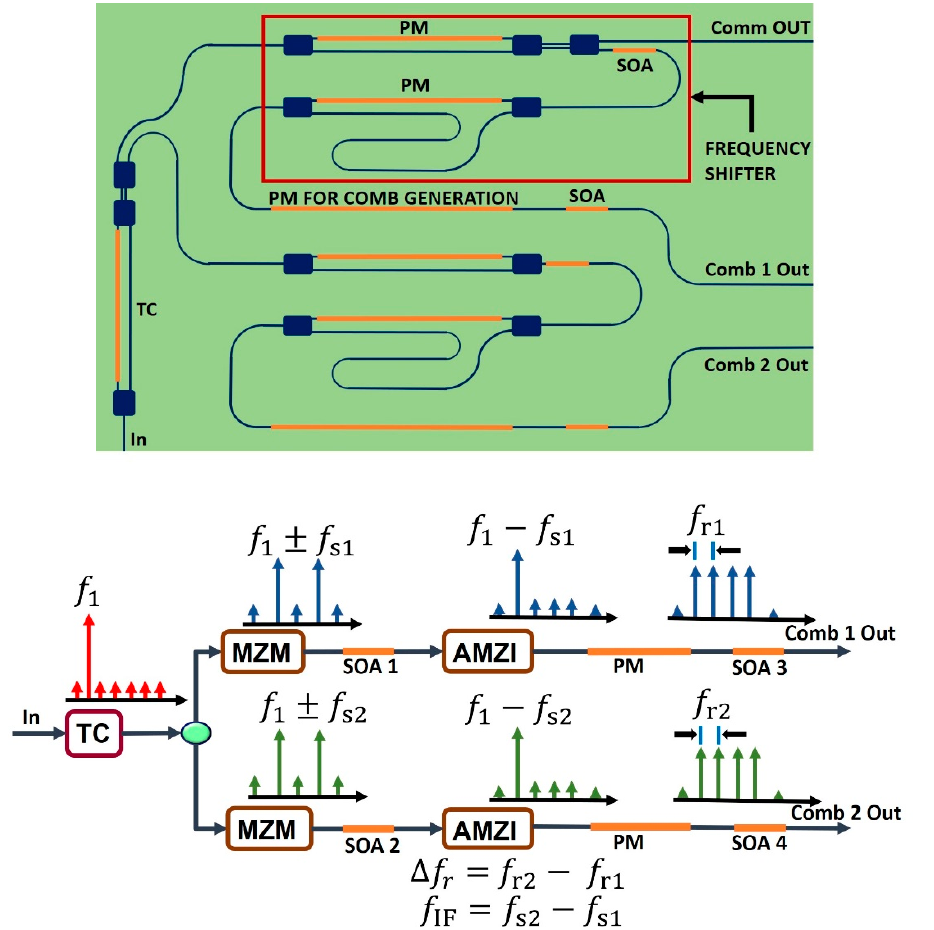
Figure 6. ( Up ) Architecture of the frequency shifter and Dual-Comb stages. The TC is used to select the operation mode. The SOA of the frequency shifter can be biased to absorb the power and prevent the doubling of the telecommunication signal. The first PM comprises the MZM. The second one comprises the AMZI. The lower branch is a copy of the upper branch. The two frequency shifters comprise the “frequency shift stage”. The “PM for comb generation” placed in the upper and lower branches comprise the dual comb stage. ( Down ) Signal Behavior.